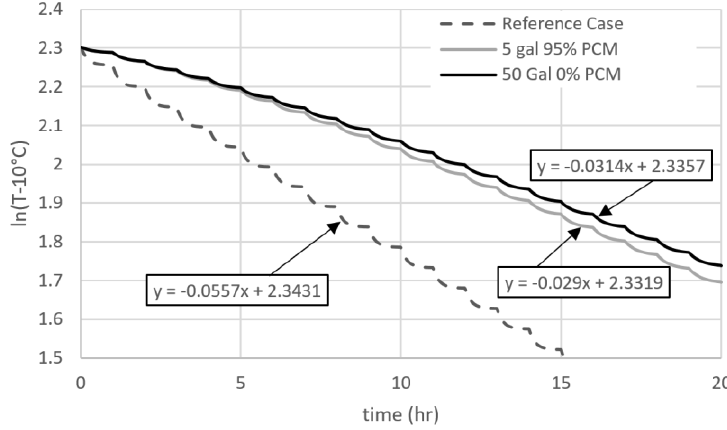
Figure 6. Building Free Response.